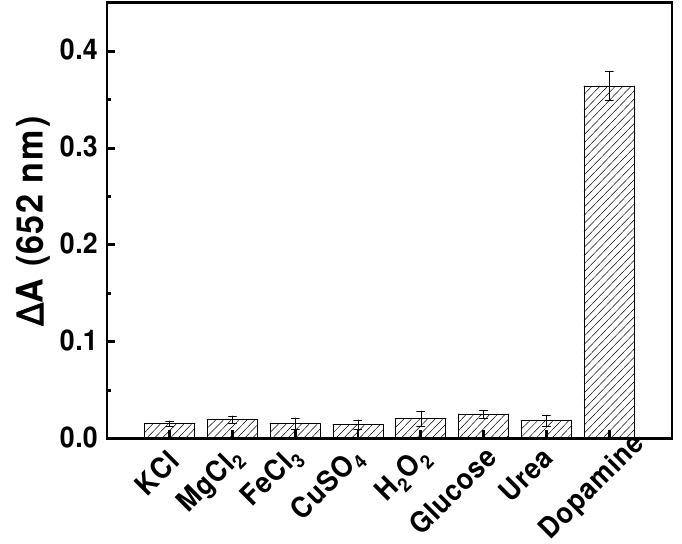
Figure 6. Change of △ A in the presence of various substances.